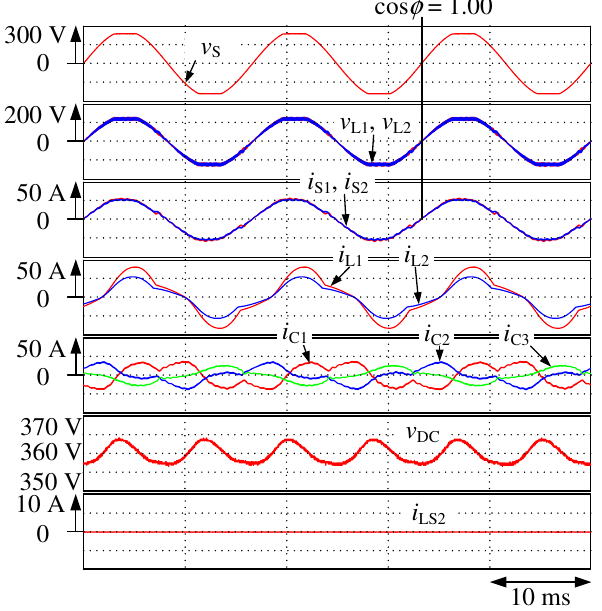
Figure 9. Experimental results for Figure 5 without battery, where BBC acts as an active power-line